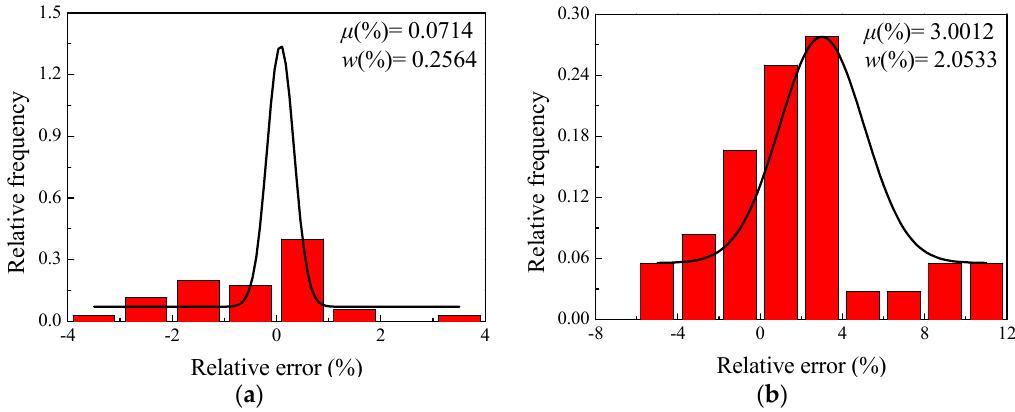
Figure 8. The relative errors distribution on the true stress points predicted by ( a ) the BP-ANN model and ( b ) the Arrhenius type constitutive equation relative to the experimental ones.